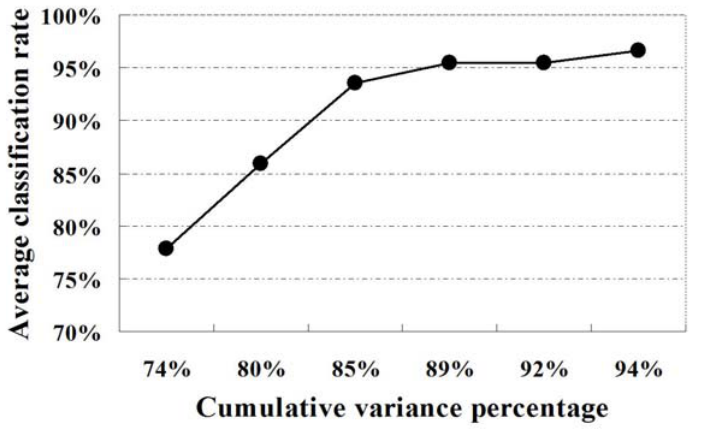
Figure 7. The average correct classification rate with respect to cumulative variance percentage of principal components.